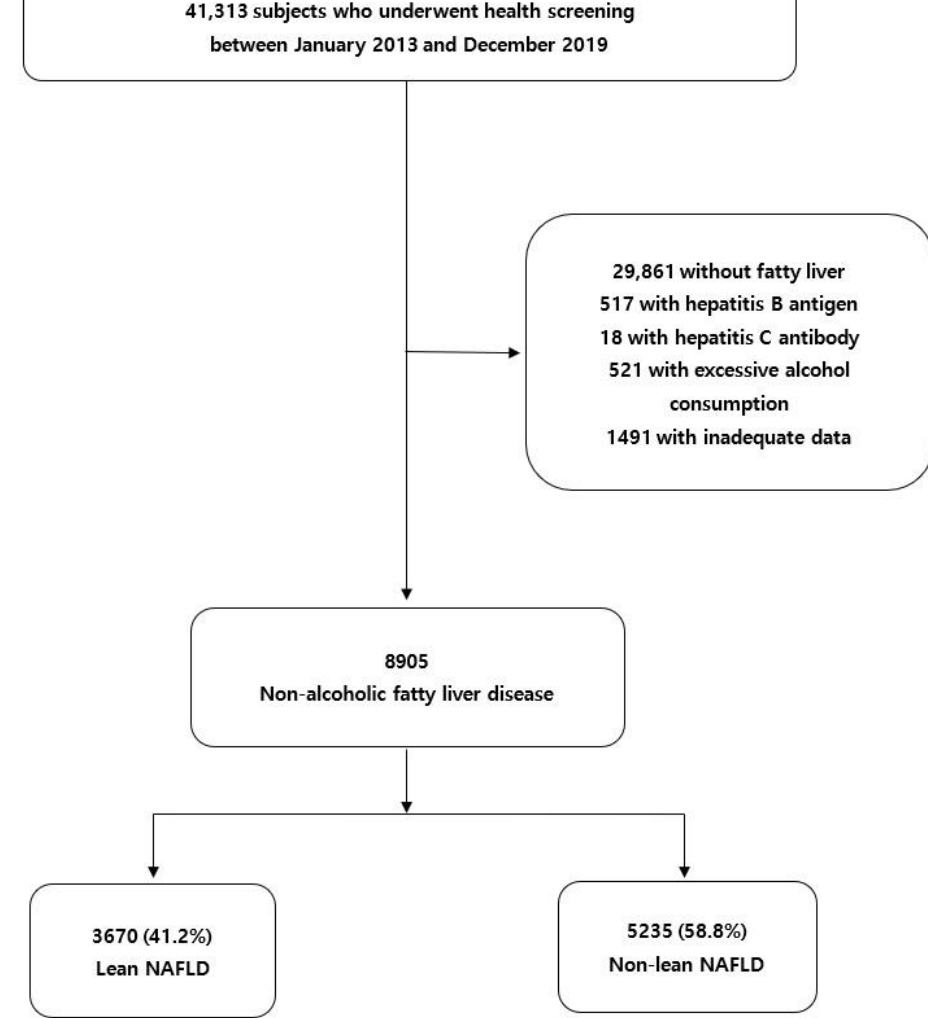
Figure 1. Flow chart of the participants. NAFLD, non-alcoholic fatty liver disease.